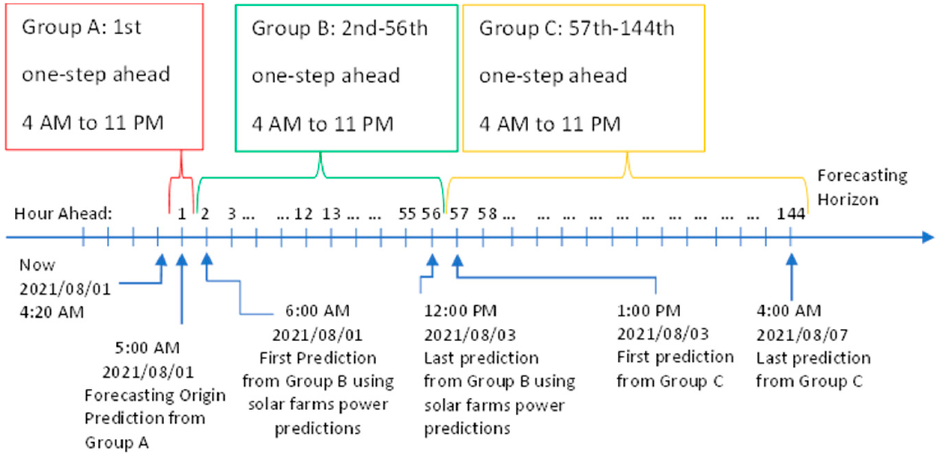
Figure 3. Group A, B, and C models to predict 1-144 h ahead.